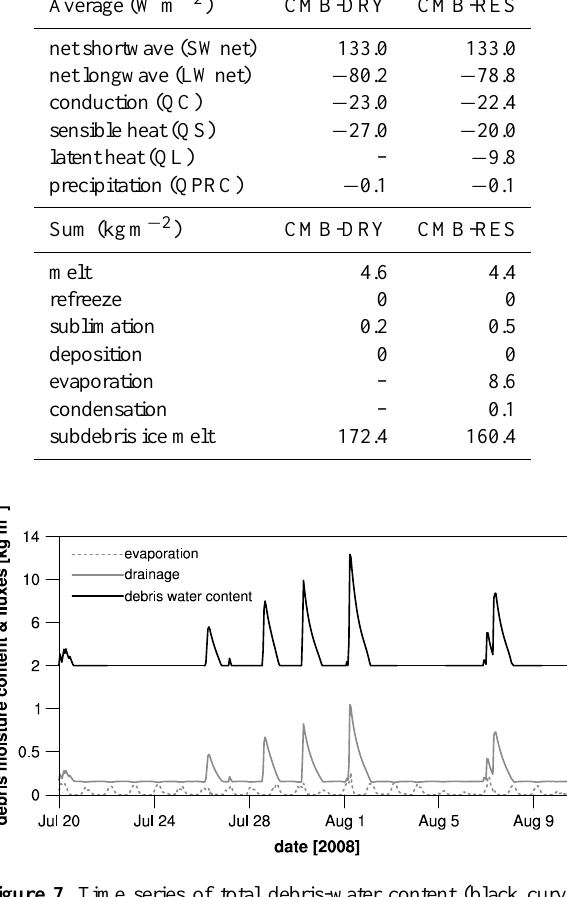
Fig. 7. Time series of total debris water content (black curve) as Figure 7. Time series of total debris-water content (black curve) well as the two sources of debris water loss: horizontal drainage as well as the two sources of debris-water loss: horizontal drainage (solid-grey curve) and evaporation (dashed- grey curve). Units are kgm − 2 . (solid-grey curve) and evaporation (dashed-grey curve). Units are in kilograms per square metre (kgm − 2